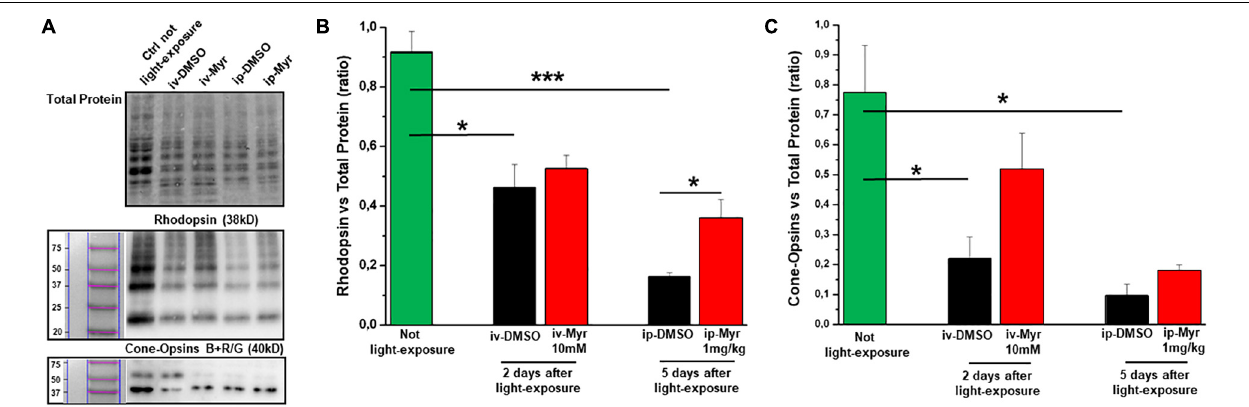
FIGURE 5 | Preservation of rhodopsin and cone-opsins level following treatment with Myriocin. (A) Representative example of WB experiment of rhodopsin and cone-opsins content. (B) Quantification by optical densitometry of rhodopsin levels in Tvrm4 animals not exposed (green bar) and treated with Myriocin (red bar) or with vehicle (black bar) by both intravitreal and intraperitoneal injection after light induction. The bar graph shows that the levels of rhodopsin are significantly reduced in the animals treated with DMSO with respect to the non-exposed controls; i.p. treatment with Myriocin results in a rhodopsin content significantly higher with respect to the group of animals treated with vehicle. (C) Quantification by optical densitometry of cone-opsins levels in Tvrm4 animals not exposed (green bar) and treated with Myriocin (red bar) or with vehicle (black bar) by both intravitreal and intraperitoneal injection after light induction. The bar graph shows that the levels of cone-opsins are significantly reduced in the animals treated with DMSO with respect to the non-exposed control. Treatment with Myriocin, by both routes of administration, leads to an increase in cone-opsins levels, although not statistically significant. Values are shown as mean ± SEM ( n = 3, for each analyzed group); * p ≤ 0.05, *** p ≤